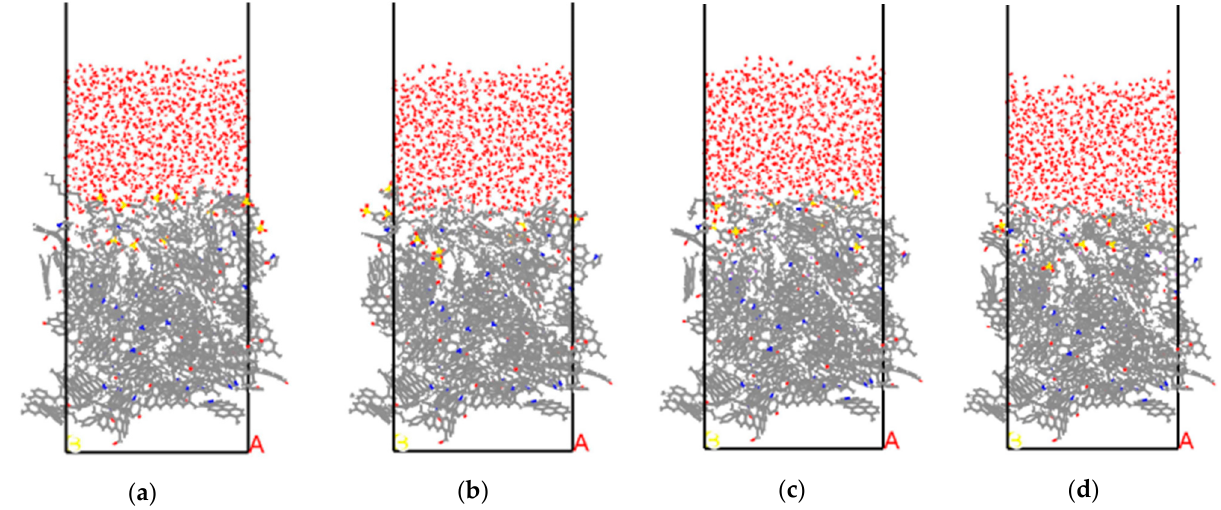
Figure 9. Equilibrium configuration of the water/surfactant/anthracite system after MD simulation ( a ) 2-C16; ( b ) 4-C16; ( c ) 6-C16; ( d ) 8 ‐ C16.